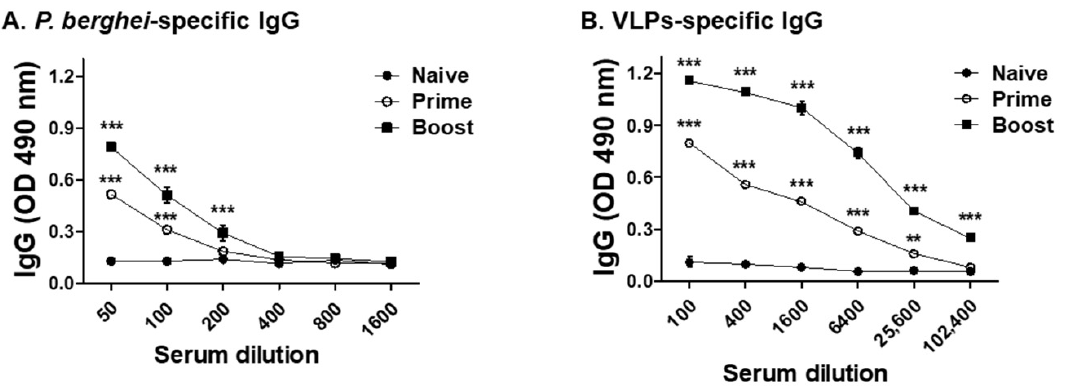
Figure 3. IgG antibody response. Mice were intramuscularly immunized twice with the mixture of MSP-8, MSP-9 and RAP1 VLPs. Sera ( n = 6) were collected at regular intervals after each immunization with the VLPs. VLPs immunization induced IgG antibodies reacted with P. berghei Ag ( A ) and VLPs ( B ) upon prime and boost compared to naïve sera (** P < 0.01, *** P < 0.001).